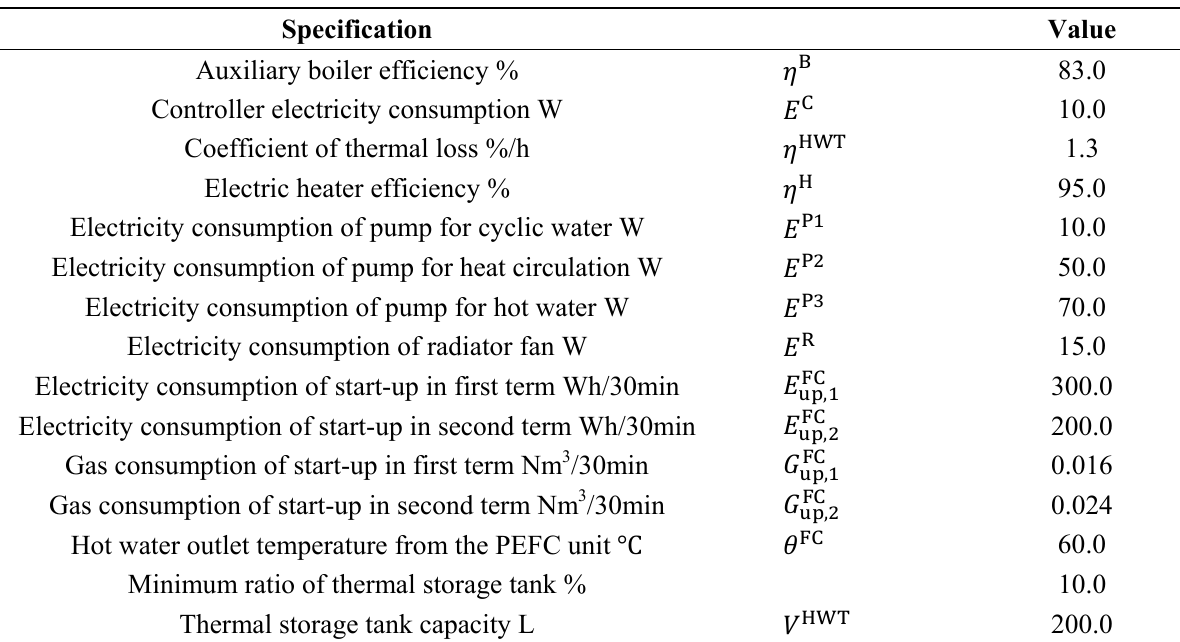
Table 3. PEFC-CGS